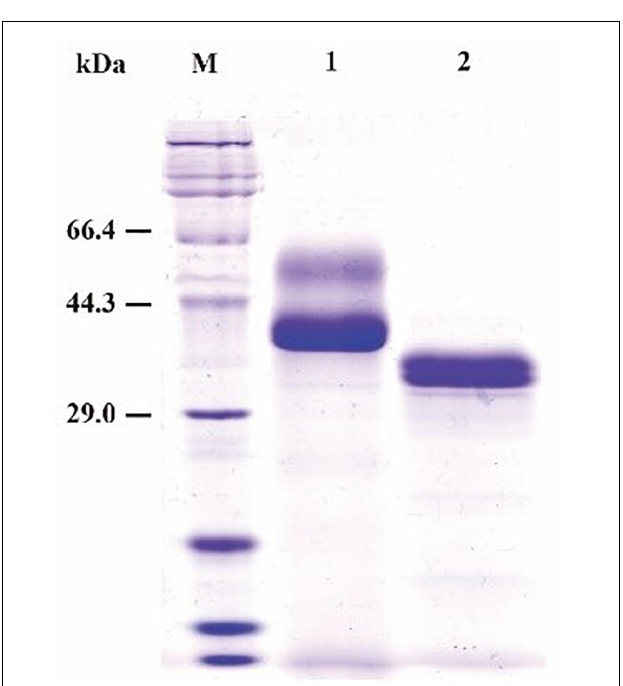
FIGURE 2 | SDS-PAGE assay of the recombinant BspPel. Lane M: protein marker; lane 1: purified recombinant BspPel; lane 2: purified recombinant BspPel treated by PNGase